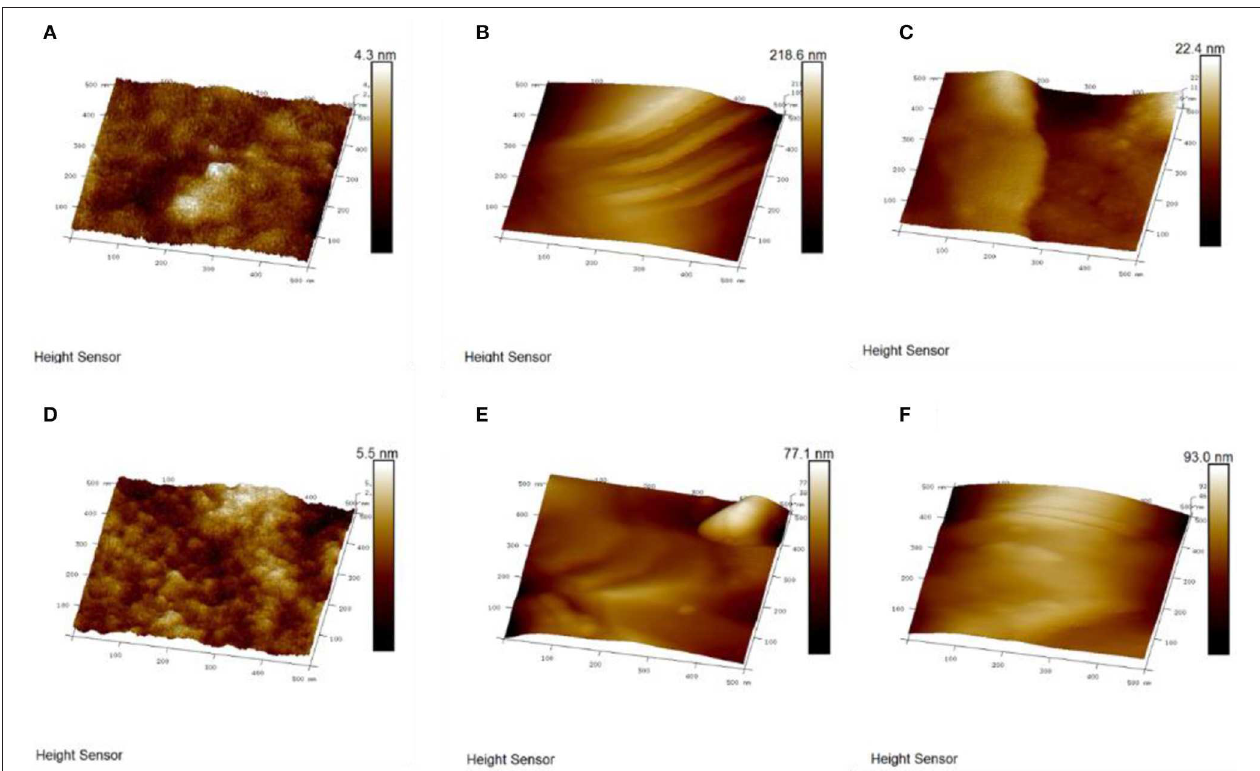
FIGURE 14 | A three-dimensional diagram of the sample surface obtained from AFM with different holding times: (A) 30min; (B) 60min; (C) 90min; (D) 120min; (E) 150min; (F) 180min.